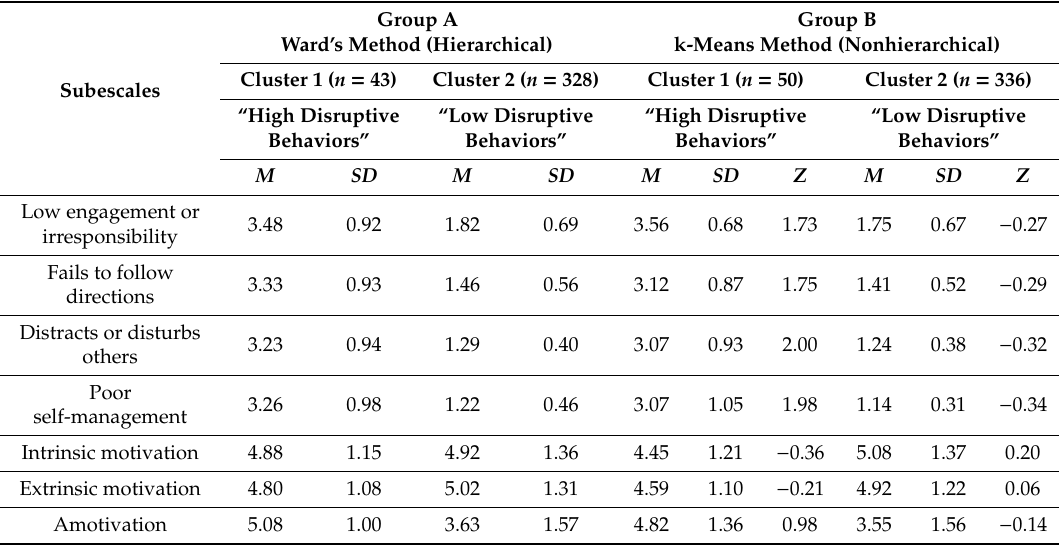
Table 2. Clusters of group A and group B following hierarchical method (Ward) and nonhierarchical method (k-means).